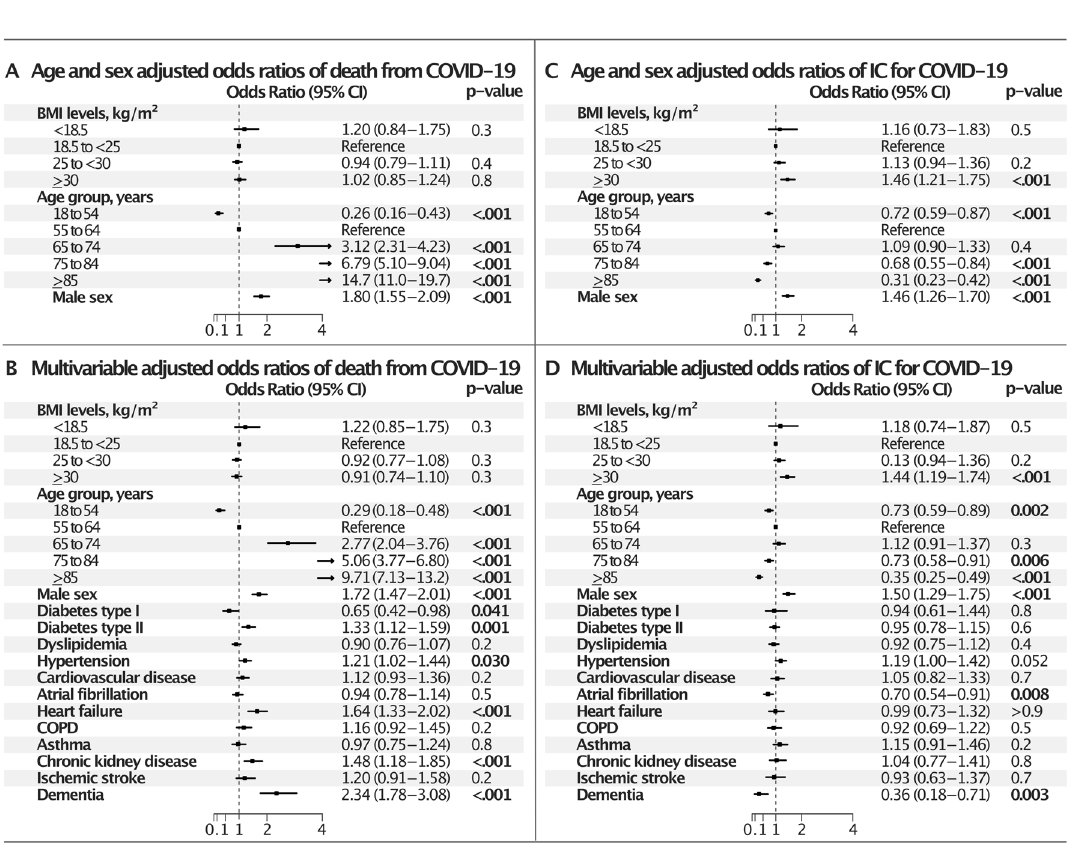
Figure 1. Number and percent of population who survived and died by regular care vs. intensive care. A considerable majority of all hospitalized patients were treated in regular care and survived. RC regular care, IC intensive care.